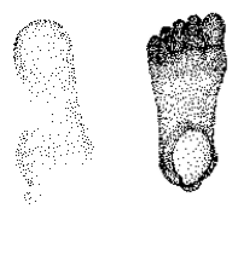
Fig. 11. Attitude